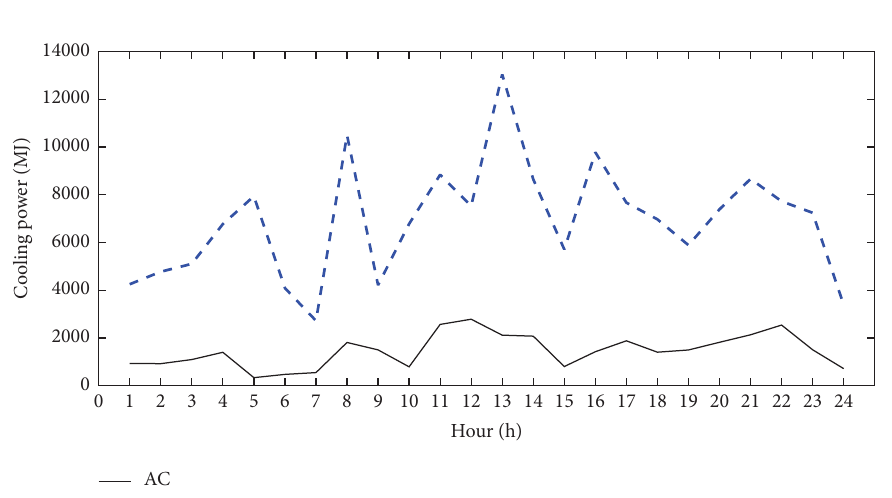
Figure 9: Cooling dispatch in winter.